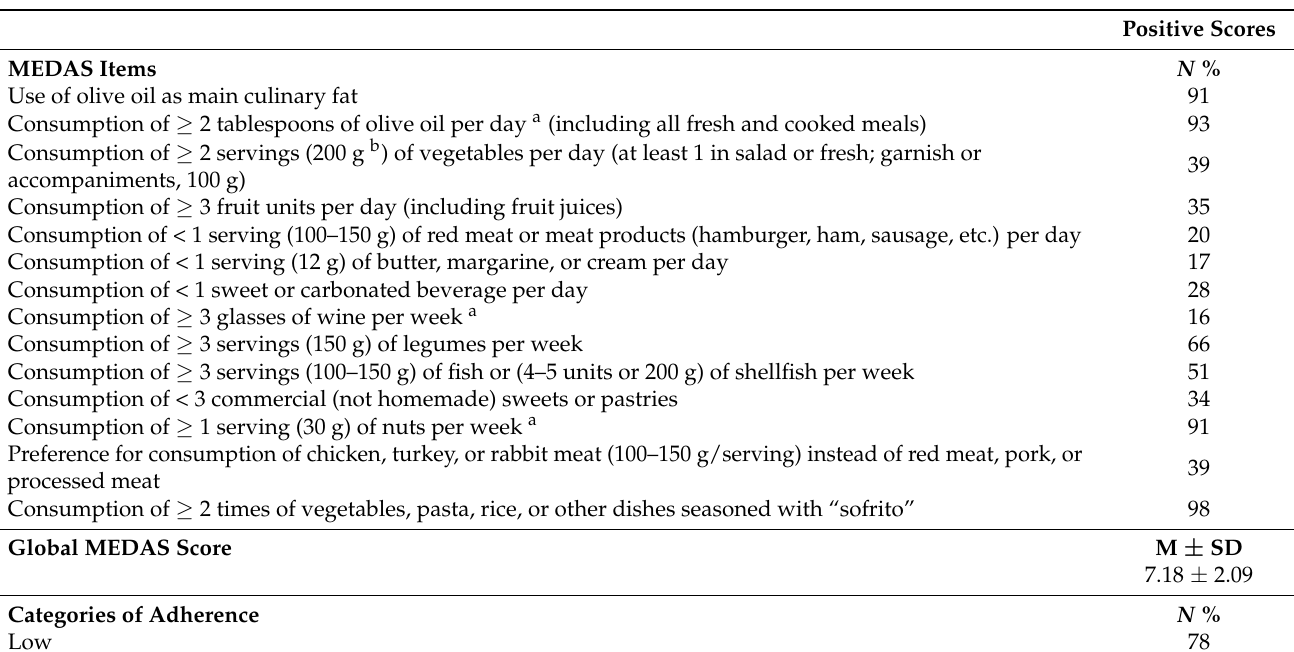
Table 2. Response frequencies to the Mediterranean diet adherence screener (MEDAS).